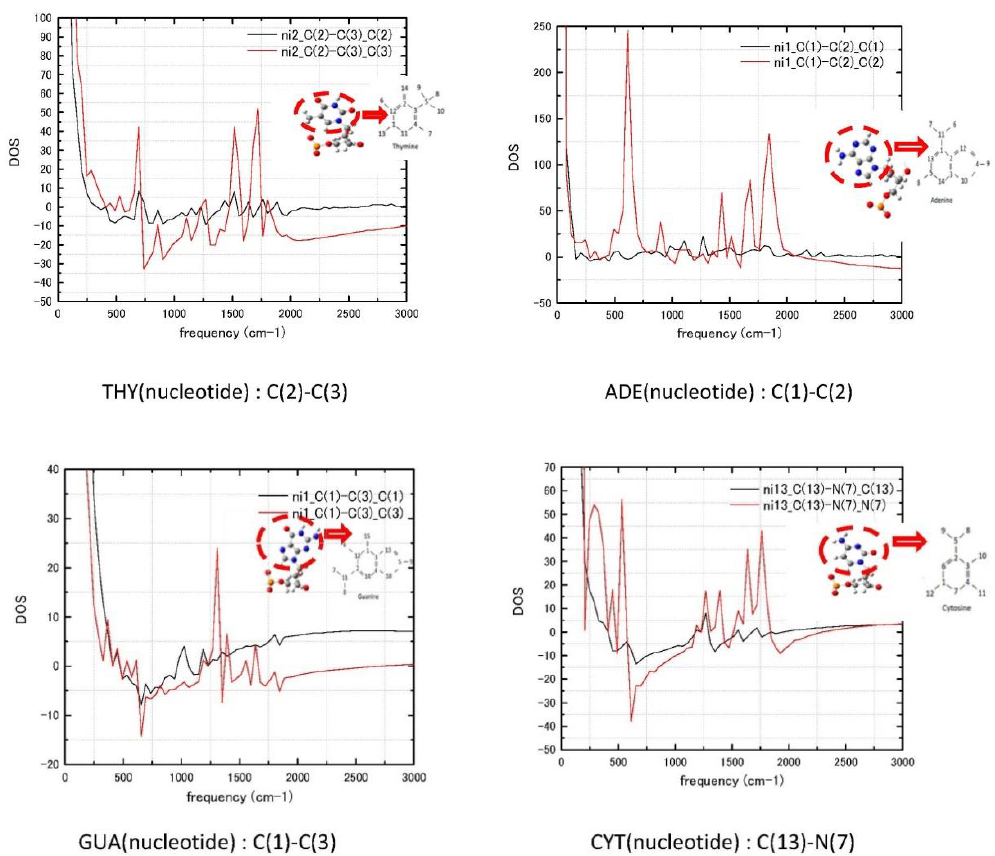
Figure A1. Stretching spectra of adenine, guanine, thymine C(1) – C(2) – C(3) bonds for atoms in hexagonal ring of the base, C(13) – N(7) stretching frequencies of cytosine in the base-to- 2′ -deoxyribose bond, see numbering in the inserted scheme of each base. Red and black colors mark the i-j bond from the i and j side. Atoms at the side of the bond are written after the bond: X-Y X. Each bond between atoms i and j includes the projection of the vectors 𝑣̅ 𝑖 and 𝑣̅ 𝑗 on the bond ’ s 𝑟̅ 𝑖𝑗 vector. Investigated spectra for each bond are evaluated from velocity autocorrelations for i and j atoms and are shown in black and red in the figures. Since each atom participates in several bonds ’ vibrations, calculated spectra contain low am- plitude bands of adjacent bonds. The valid frequency range is 100 – 2000 cm − 1 . The calcu- lations of spectra were done for approximately 16 ps, with the time step equal to 0.2 fs, at 40 cm − 1 resolution. The Tables of calculated vibrational bands for the four types of nu- cleotides and their bases are collected in Supplementary Materials.